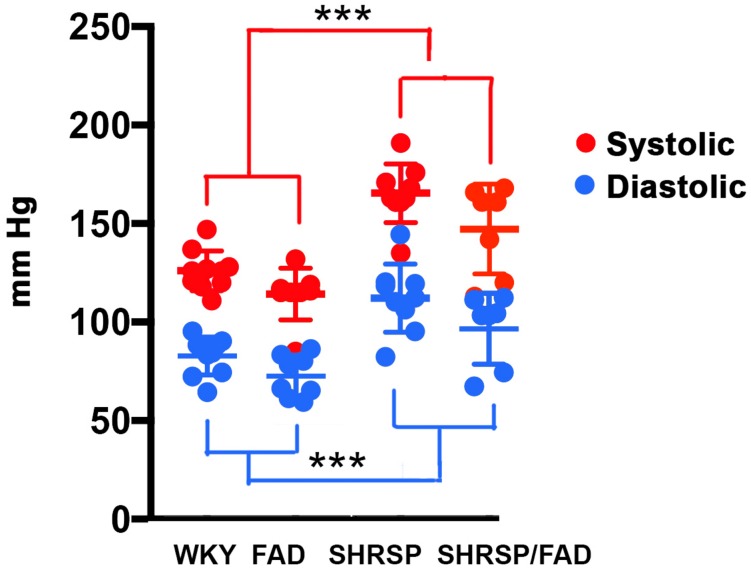
Systolic and diastolic blood pressure is elevated in SHRSP and SHRSP/FAD rats. Shown are systolic (red) and diastolic (blue) blood pressure measurements in FAD (n = 11), SHRSP (n = 10), and SHRSP/FAD (n = 9) rats, as well as non-transgenic WKY controls (n = 8), as measured in the rats’ caudal tail artery. The multivariate analysis showed a significant effect of SHRSP only (p < 0.0001), indicating that SHRSP but not sex or FAD transgene influenced blood pressure. Similarly the univariate F tests showed significant main effects of SHRSP on both diastolic and systolic pressure (p < 0.0001 and p < 0.0001, respectively). The univariate effect of FAD on diastolic and systolic pressure was significant (p < 0.019, respectively), but post hoc analysis showed that the trend for slightly higher pressure in SHRSP/FAD rats was marginal and not significant. Post hoc analysis showed that both systolic and diastolic pressure were higher in SHRSP and SHRSP/FAD rats than in WKY and FAD (p < 0.001), consistent with preservation of the SHRSP hypertensive phenotype in the SHRSP/FAD rat. Data represent means ± SEM. ∗∗∗p < 0.001; MANOVA with Pillai’s Trace. Log transformation of data was performed to establish homogeneity of variance.